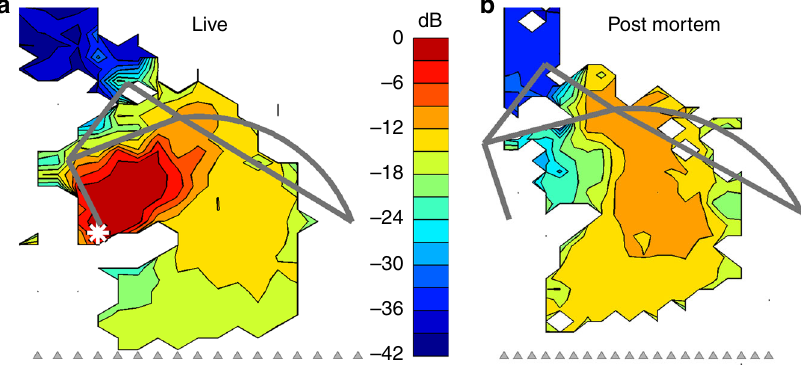
Fig. 4 Post-mortem disappearance of a vibration hotspot. a In vivo vibration map for the 11.2 kHz component of a 65-dB-SPL multi-tone stimulus, showing a clear hotspot in the OHC/Deiters ’ cell region. b Post-mortem vibration map at the same frequency, and evoked by the same stimulus in the same cochlea, within 30 min after death. Vibration magnitudes in both panels are expressed in decibels relative to the 2.6-nm maximum observed in vivo at the location marked with the white asterisk in a . The hotspot vibrations reduce at least 10-fold (i.e., 20 dB) post-mortem, while vibrations elsewhere in the body of the organ of Corti increase and BM vibrations remain essentially unchanged. Preparation RG17793, CF 20